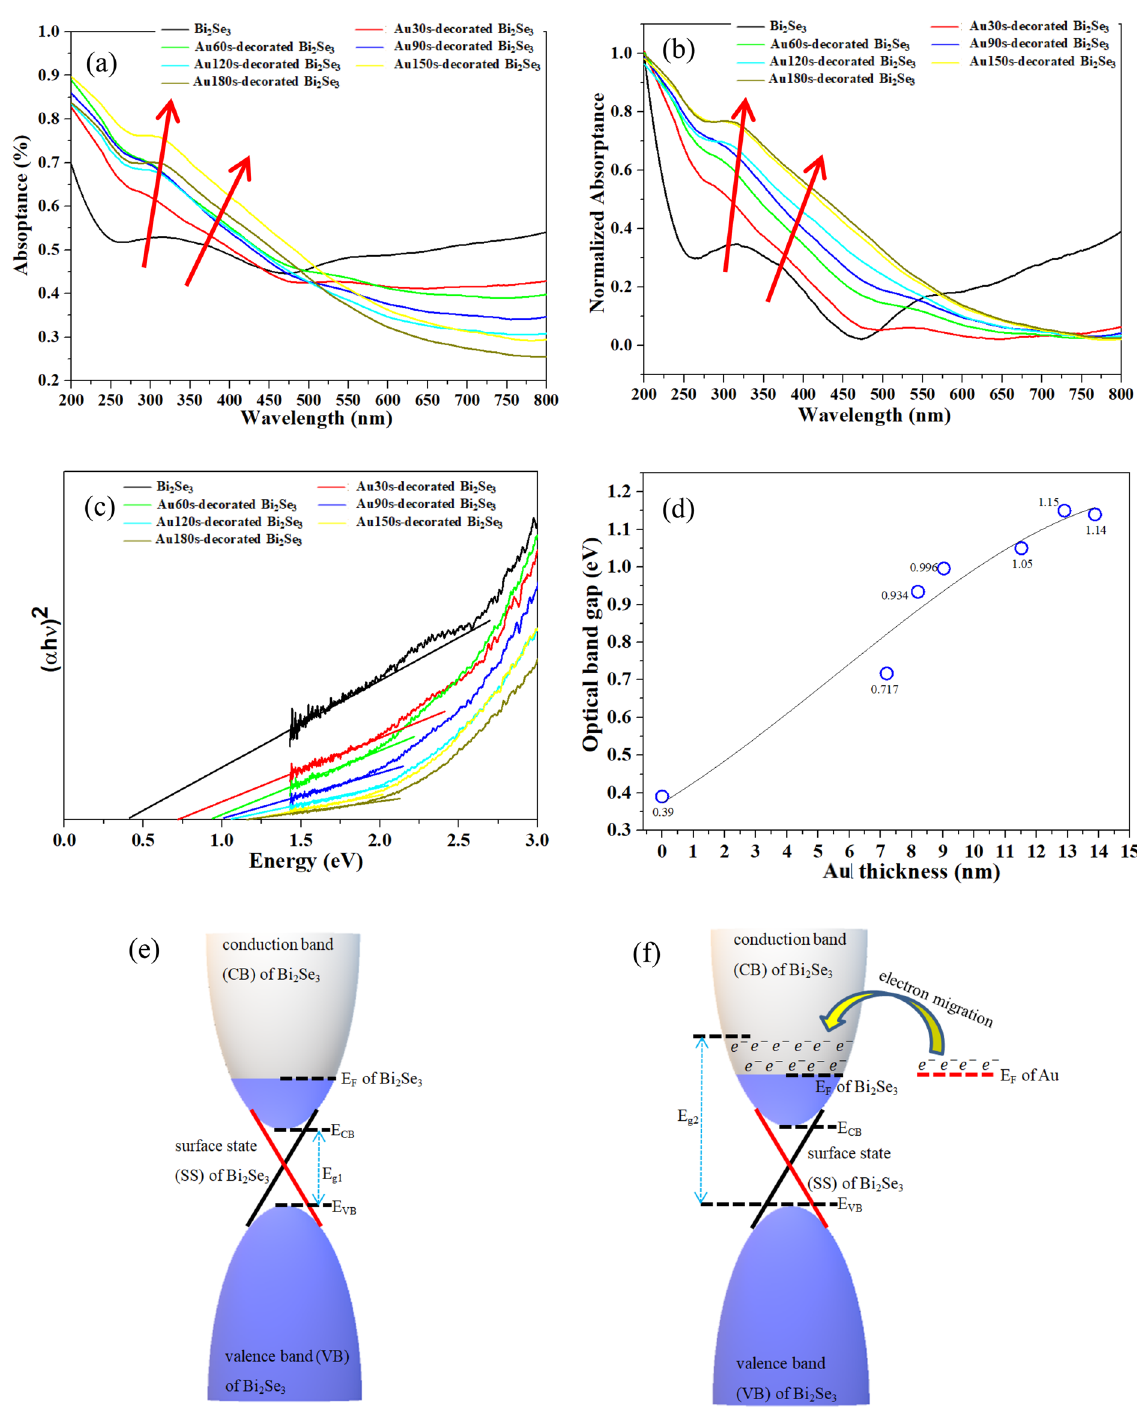
Figure 6. UV–visible spectra of ( a ) absorptance, ( b ) normalized absorptance, ( c ) Tauc-plot, and ( d ) optical band gap of Au-decorated Bi 2 Se 3 NPs. ( e ) the schematic band structures of the pure Bi 2 Se 3 , and ( f ) the proposed mechanism of the electron migration between the Bi 2 Se 3 and